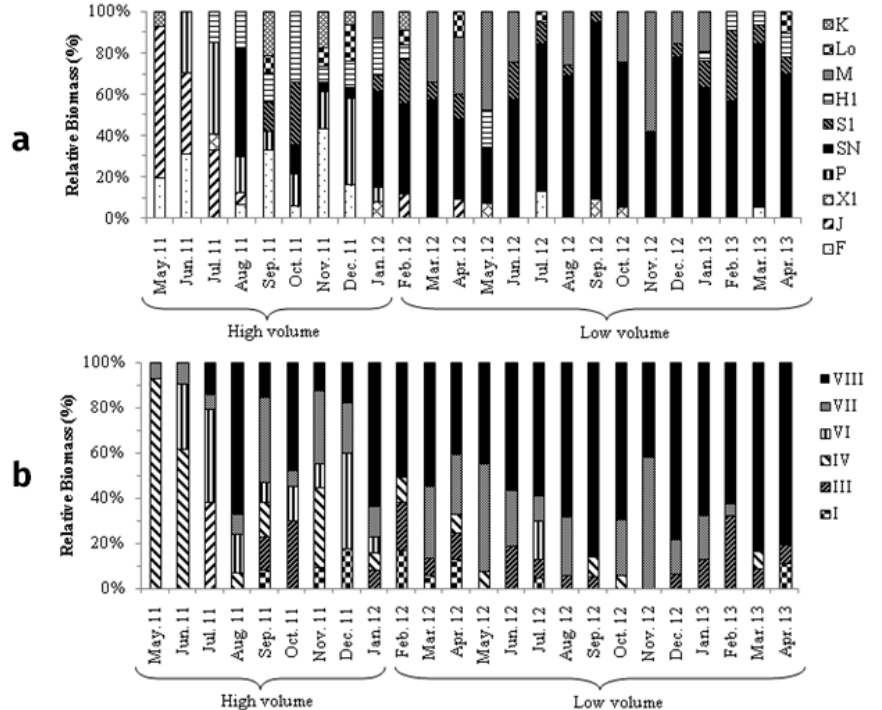
Figure 5. Relative biomass variation of Reynolds’ Functional Groups ( a ) and Morphology-Based Funcional Groups ( b ) along the